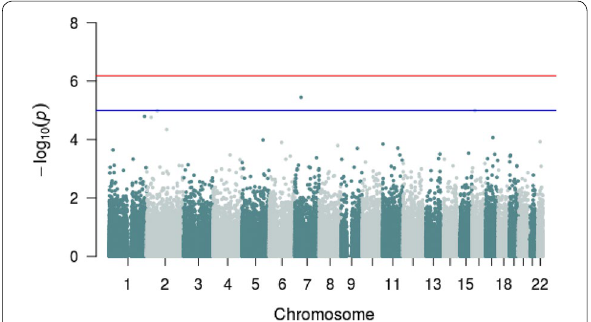
Fig. 3 Manhattan plot for association between DNA methylation and total LEQ scores. The horizontal red line represents the epigenome‑wide significant threshold for this study ( p < 6.6 and the blue line represents a suggestive significance threshold ( p < 1.0 10 − 5 ×